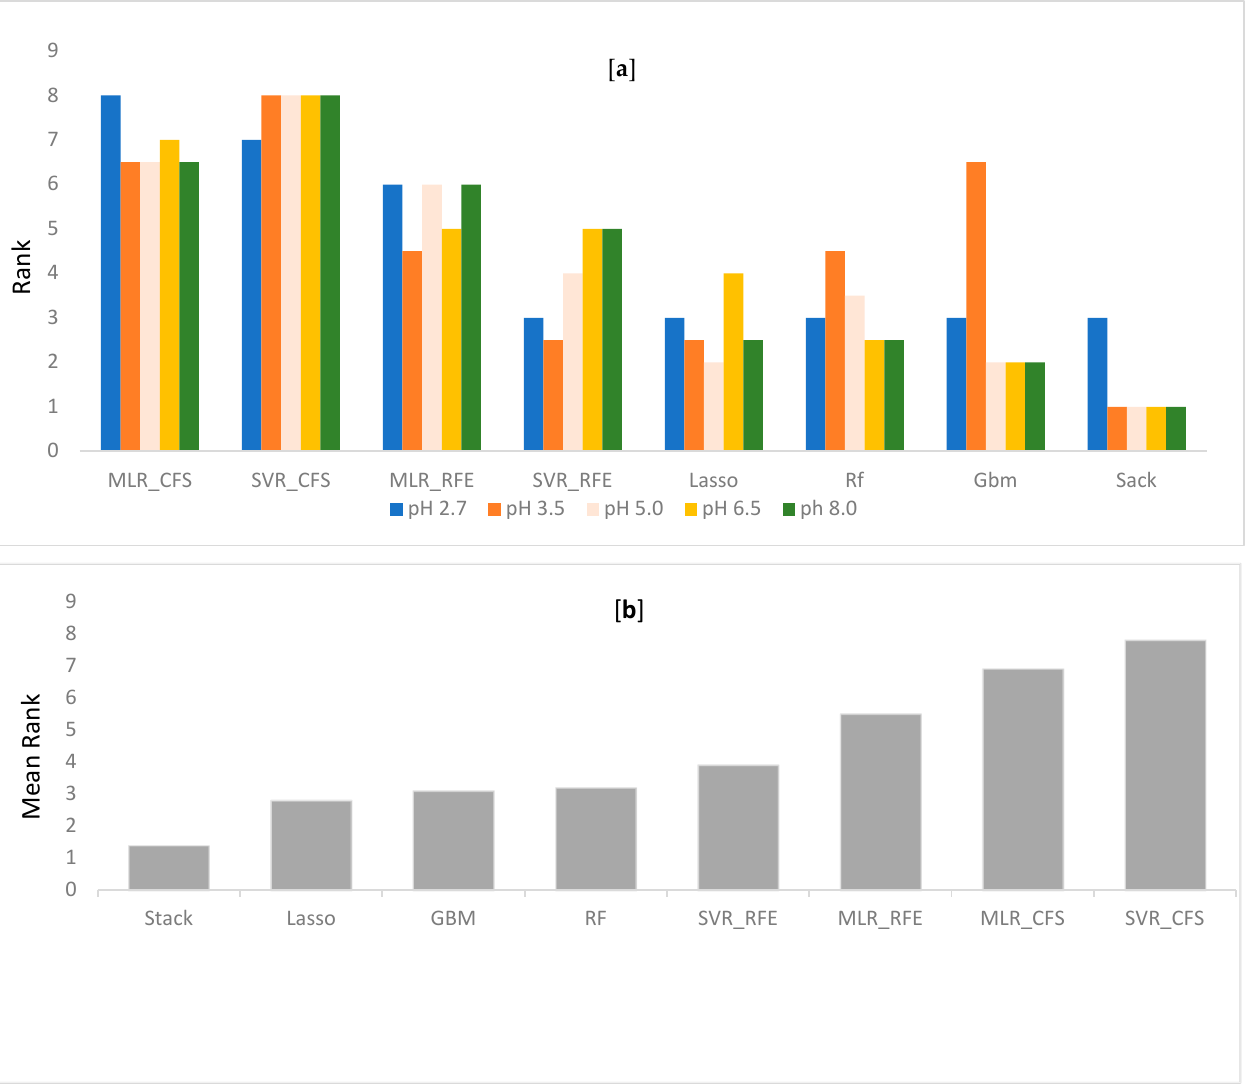
Figure 2. ( a ): Rank of every algorithm based on RMSE along the dataset. ( b ): The mean rank over all datasets when the performance is sorted on RMSE.